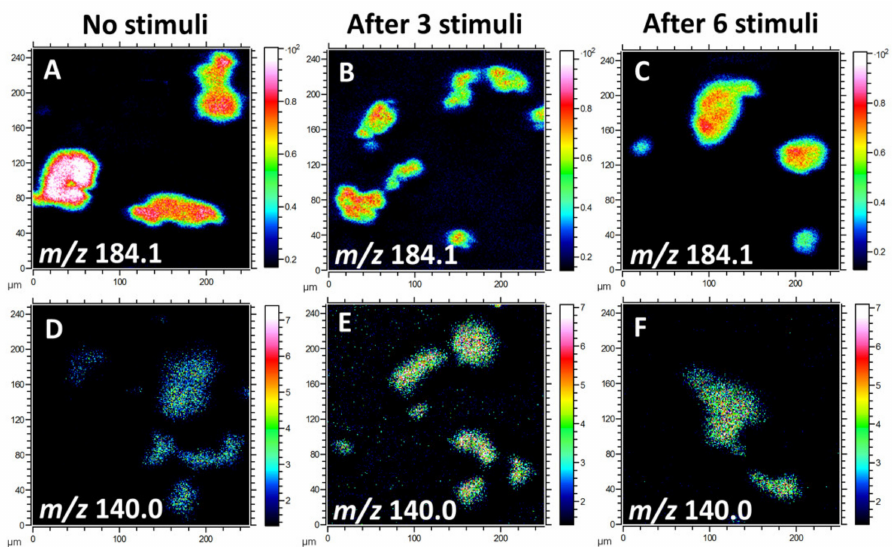
Figure 1. ToF-SIMS images of the lipid fragments from the plasma membranes of freeze-dried pheochromocytoma (PC12) cells with 0, 3, or 6 repetitive stimuli, showing the localization and intensities of lipid fragments in the positive and negative ion modes. ( A – C ) Fragment ion of phosphatidylcholine (PC) species at m / z 184.1 and ( D – F ) phosphatidylethanolamine (PE) fragment ion at m / z 140.0. A ToF-SIMS analysis was performed with 25 keV Bi 3 ++ as primary ions. The total ion dose was 1 × 10 12 ions / cm 2